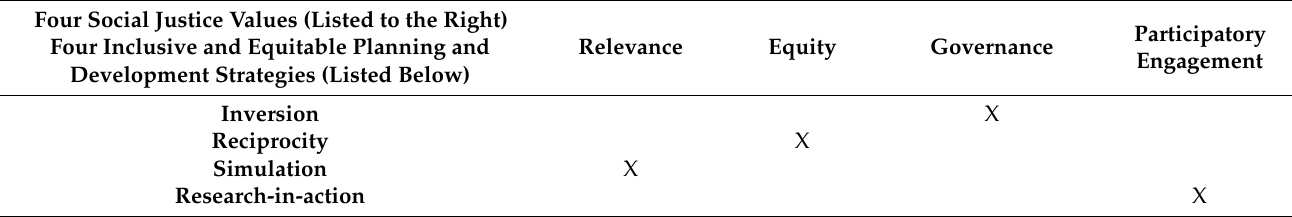
Table 2. Inclusive and equitable planning strategies and social justice